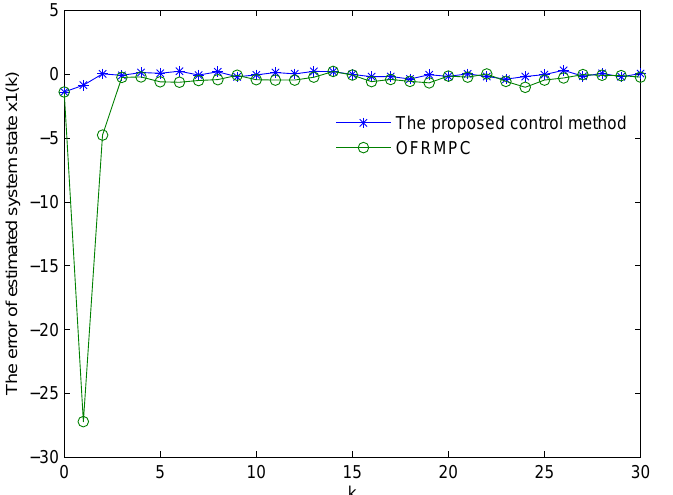
Figure 3. The estimated error of system state x1 for the proposed method and OFRMPC method.